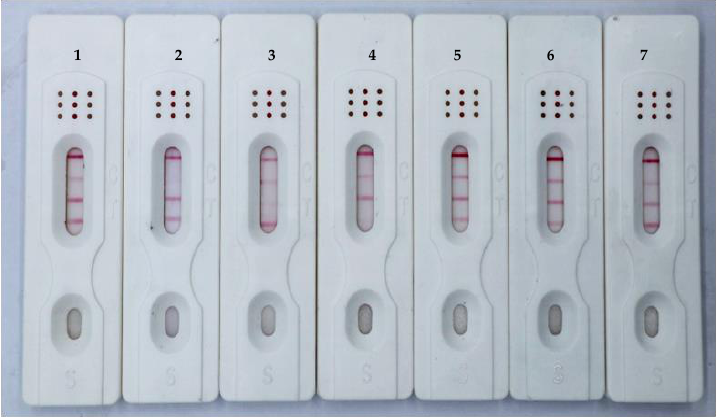
Figure 7. Specificity of ICS (Toxin standard species and concentrations). The concentrations of the toxins were as follows: blank control (1), AFB 1 , 0.5 ng/mL (2); ZEN, 5.0 ng/mL (3); T-2, 5.0 ng/mL (4); FB, 100 ng/mL (5); DON, 100 ng/mL (6); OTA, 100 ng/mL (7). The assembled ICS was packaged in a plastic Ziplock bag and placed at 25 °C for 120 days to detect color changes at the C and T lines of the blank control group and the posi- tive test group. The results showed that the ICS blank control group showed a similar color to the unsaved blank group after storage for different times. Moreover, the positive test group and the blank group showed the same color (Figure 6D). Thus, our findings demonstrated that the storage method used in this study had only minor effects on the color development and sensitivity of the ICS and that ICS had good stability. 3.5. Analysis of Mycotoxins in Real Samples Thirty different medicinal and edible food and traditional Chinese medicine samples were purchased from local pharmacies and online sales. After extraction with methanol, the extract was diluted 10 times with PBST, and the test sample solution was evaluated using the developed ICS. The results (Figure 8) showed that sample nos. 13 and 15 (both of sand jujube kernels) were positive. At the same time, the samples were tested using HPLC and ELISA (Tables 1 and 2). When mycotoxins AFB 1 , ZEN, and T-2 were present in the samples at a concentration lower than 5.0 μg/kg, the T line of 50 μg/kg test area showed a red band, indicating negative; otherwise, the results were positive. These findings demonstrated that the ICS results were consistent with the findings from HPLC and ELISA detection. Overall, the developed ICS could simultaneously detect AFB1, ZEN, and T-2 and may have applications in the detection and analysis of medicinal and edible food and traditional Chinese medicine samples. Table 1. ICS and ELISA detection results of ZEN in traditional Chinese medicine samples. Chinese Medicine